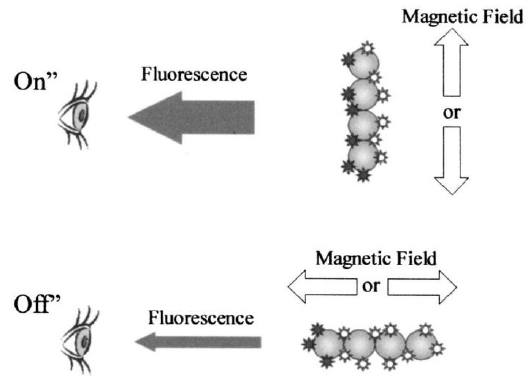
Figure 8. Sketch of an immunoassay performed on chains of magnetic particles induced by an externally applied magnetic field. The observed fluorescence intensity depends on the relative number of visible (dark stars) versus non-visible (light stars) fluorophores bound to the magnetic particles, which can be modified by varying the orientation of the applied magnetic field (On and Off state). Modified graph reprinted with permission from [219]. Copyright 2003, AIP Publishing LLC.